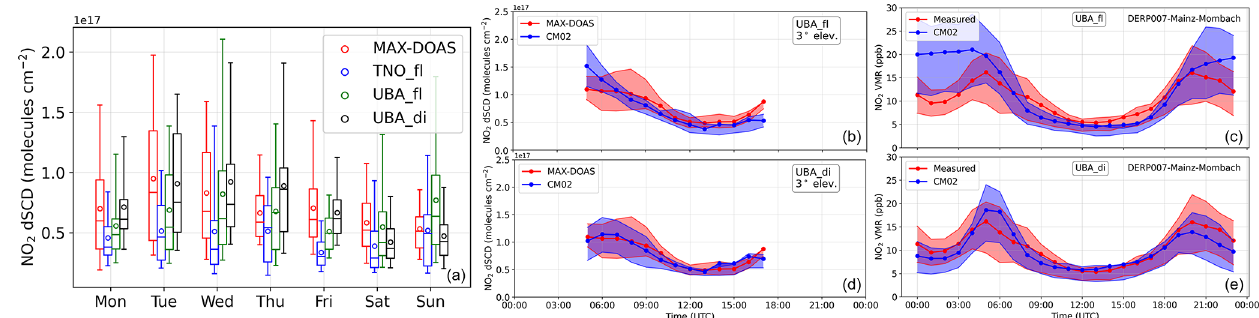
Figure 13. (a) Box and whiskers plot showing the distribution of NO 2 dSCDs at 3 ◦ elevation angles for MAX-DOAS and the three different model set-ups for different days of the week. Mean hourly diurnal profiles of measured and simulated NO 2 dSCDs at 3 ◦ elevation angle for T1 for the UBA fl (b) and UBA di (d) set-ups. The shaded region above and below the mean line denote the 75th and 25th percentiles, respectively. Diurnal profiles of measured and simulated NO 2 surface VMRs measured at a background site (Mombach, ∼ 3.5km north of MPIC) for the UBA fl (c) and UBA di (e)